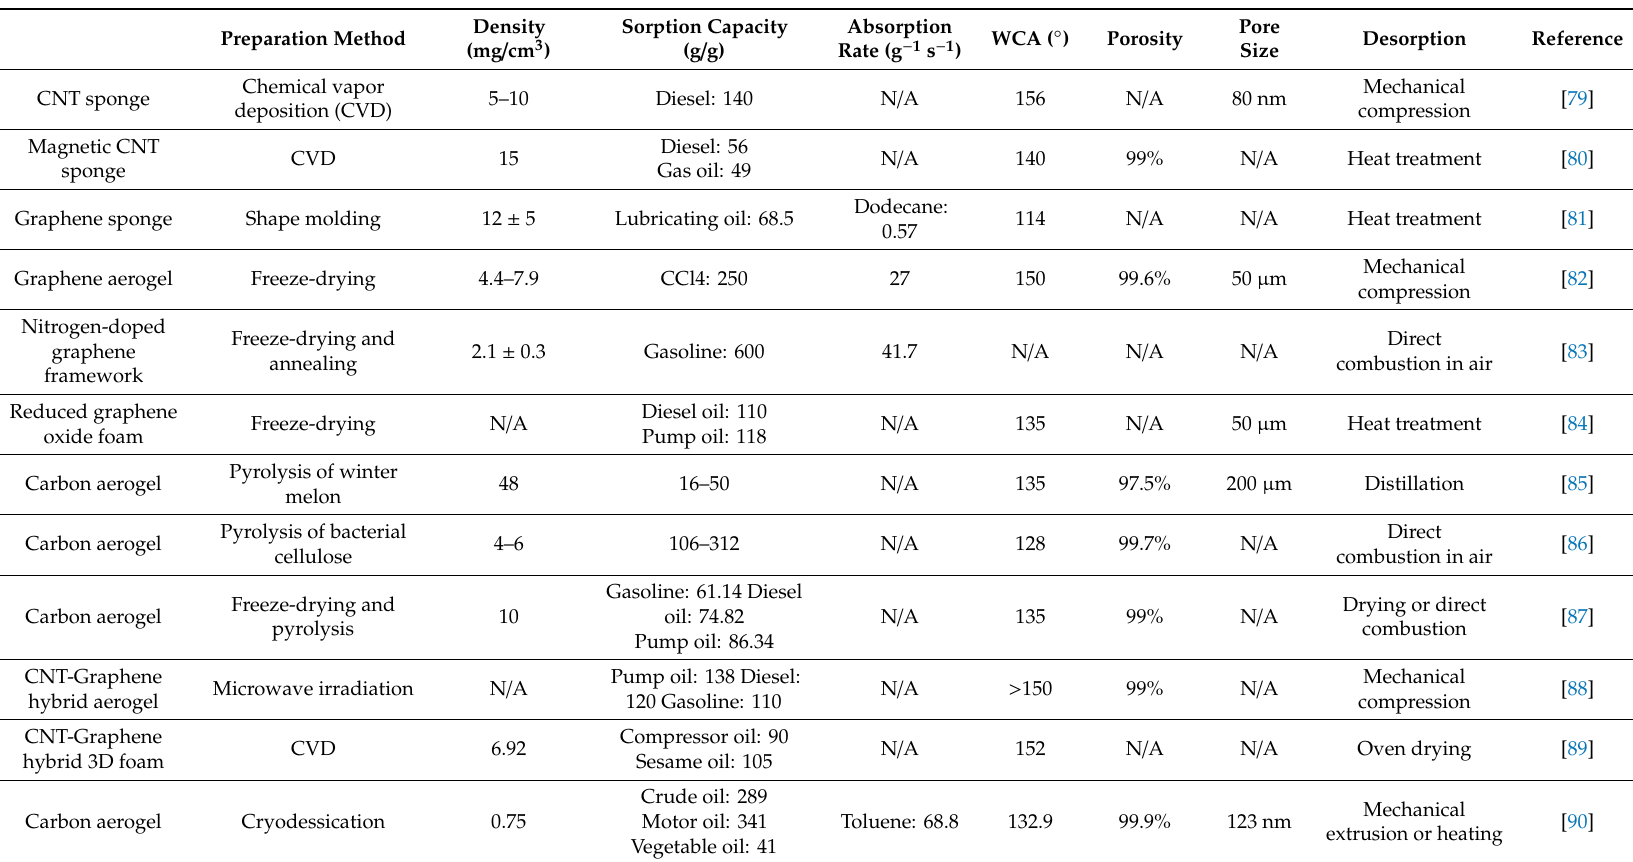
Table 4. Selected properties of carbon-based